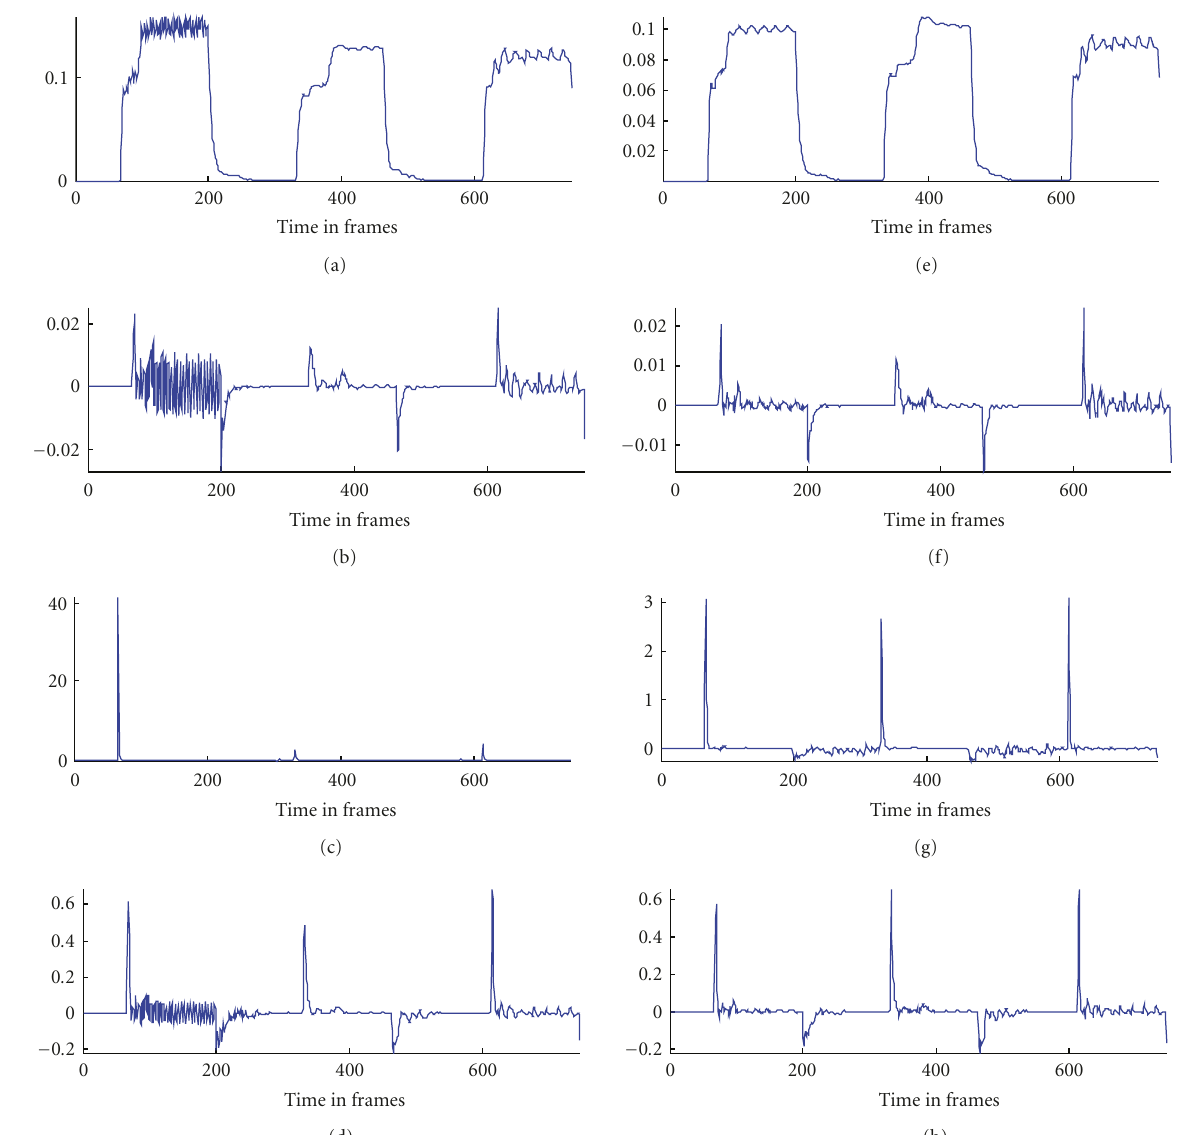
Figure 19: Comparison between the results of the proposed detection method and that based on RMS, where the plots are (a) h RMS ( k ), (b) ( k ), (c) h RMS ( k ), (d) h RMS ( k ), (e) h o ( k ), (f) h o h RMS a r b